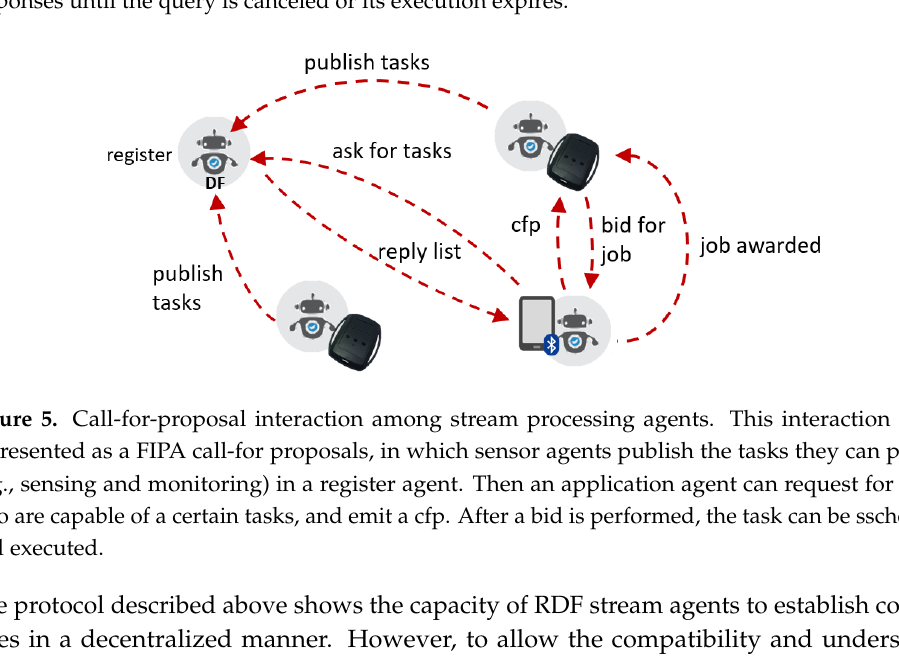
Figure 4. Simple request interaction between two sensor agents: continuous RDF Stream Processing (RSP) query. This interaction can be embedded into a FIPA request protocol, with the addition of a continuous set of final responses instead of a single one. The continuous query will expect multiple responses until the query is canceled or its execution expires.